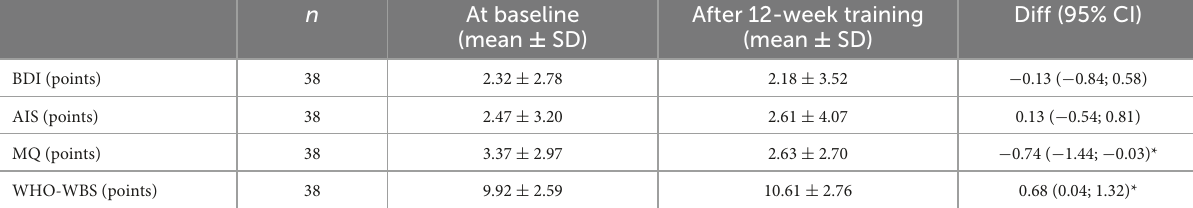
TABLE 5 Psychological Questionnaire’s scores at baseline and after training program.